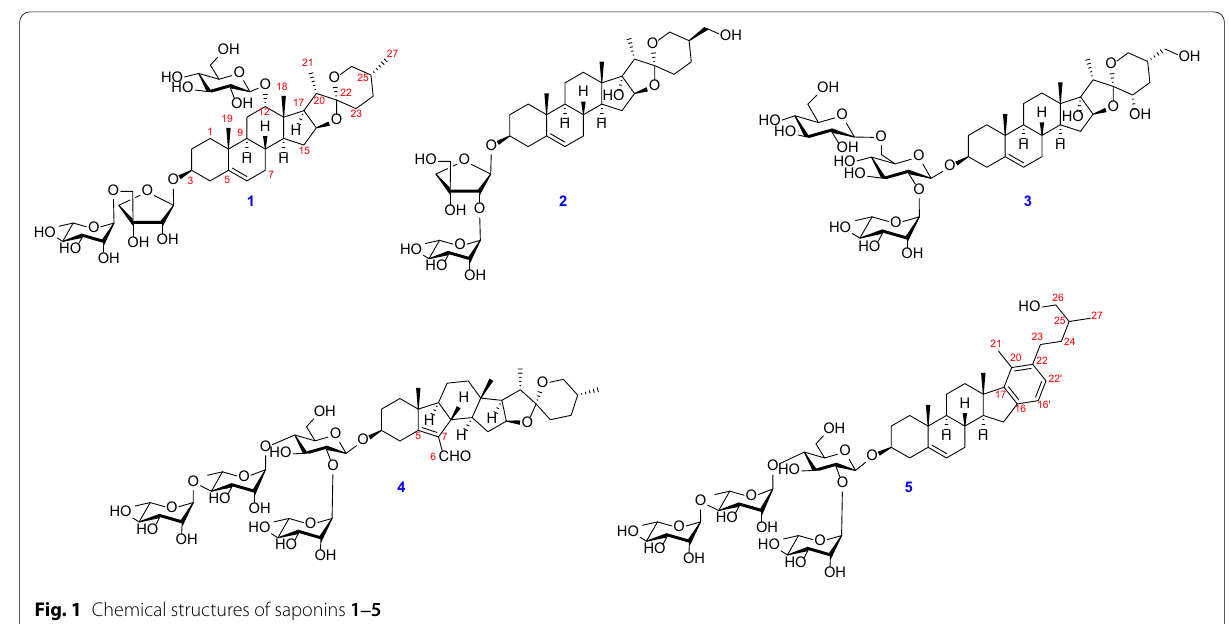
Fig. 1 Chemical structures of saponins 1 ‒